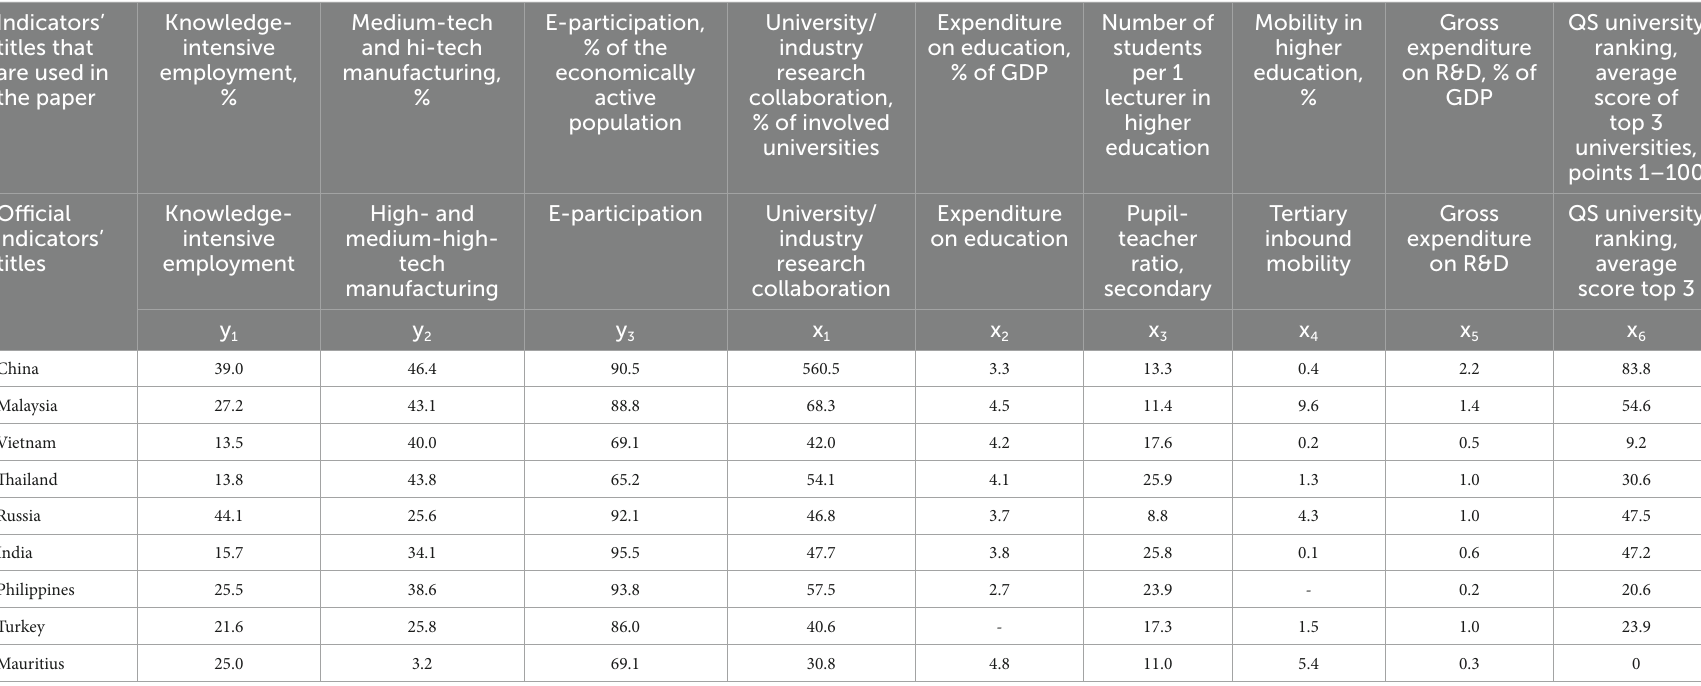
TABLE 1 Directions of higher education’s development and results for the social and investment model of economic growth in emerging economies in 2020. Indicators’ titles that are used in the